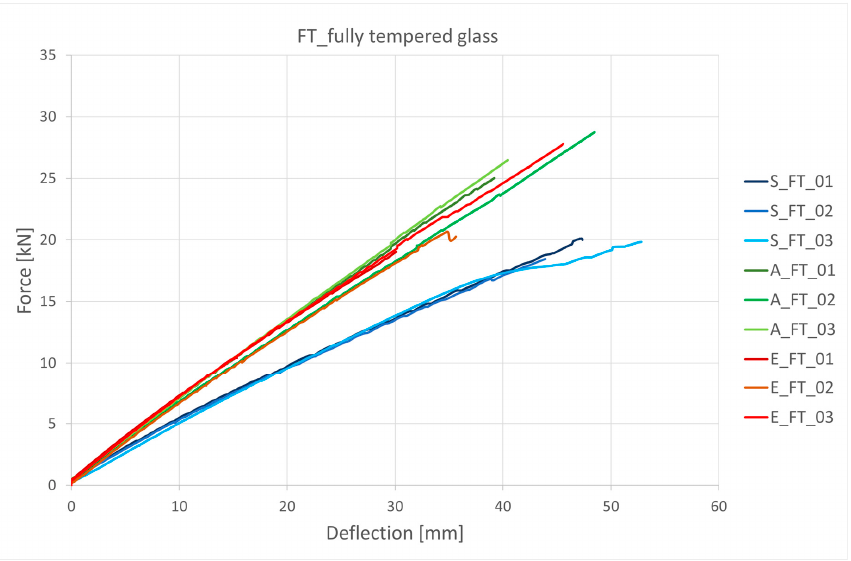
Figure 21. Diagram force vs. deflection for the fully tempered glass (adhesive: S—silicone Sika